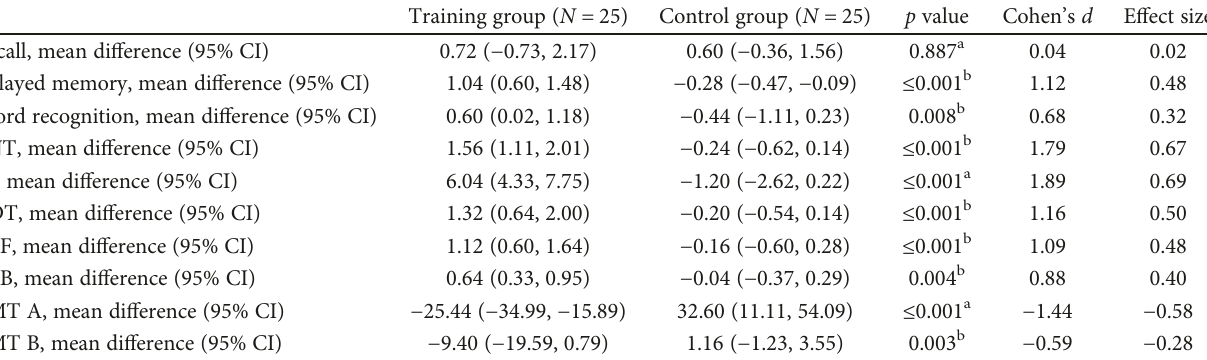
Table 4: The e ff ect of the intervention (estimated by comparing the mean di ff erence of the two neuropsychological assessments (baseline minus endpoint in each group) between the two groups (training group versus controls)) in the training group compared to the control